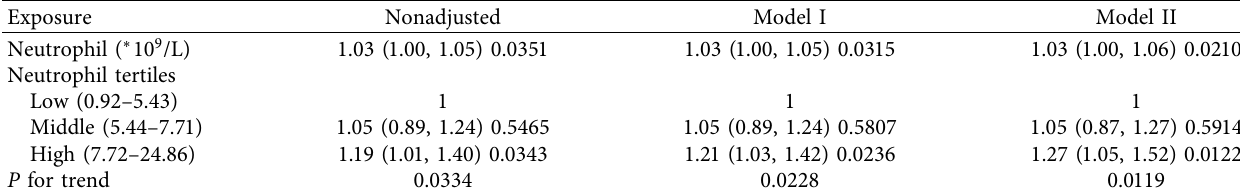
and surgery, treatment strategy, operation time, and